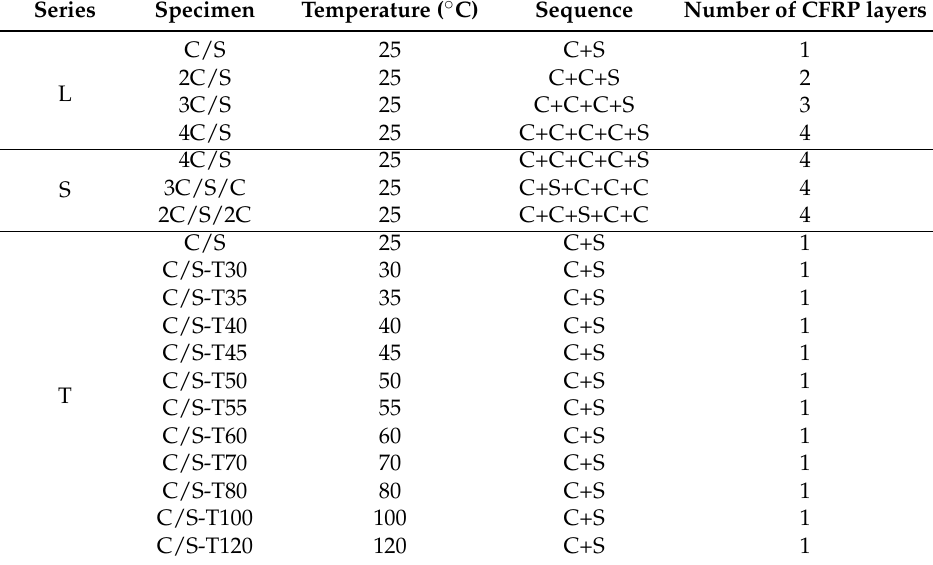
Table 1. Summary of test